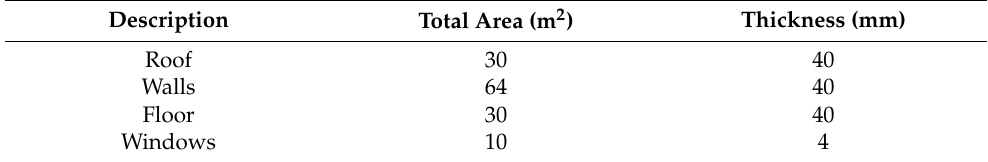
Table 4. Bus geometric data